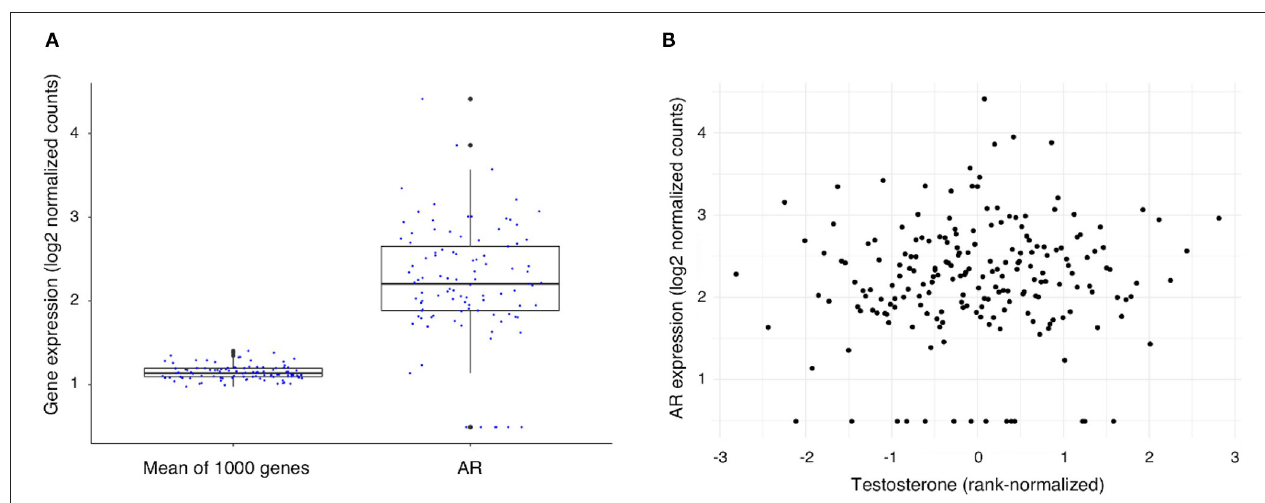
FIGURE 1 | Expression of the Androgen Receptor (AR) gene and its association with testosterone levels in men undergoing carotid endarterectomy. (A) AR gene expression levels as compared with the mean expression level of 1,000 randomly selected genes. (B) Scatterplot of testosterone level (rank-normalized) and AR gene expression in